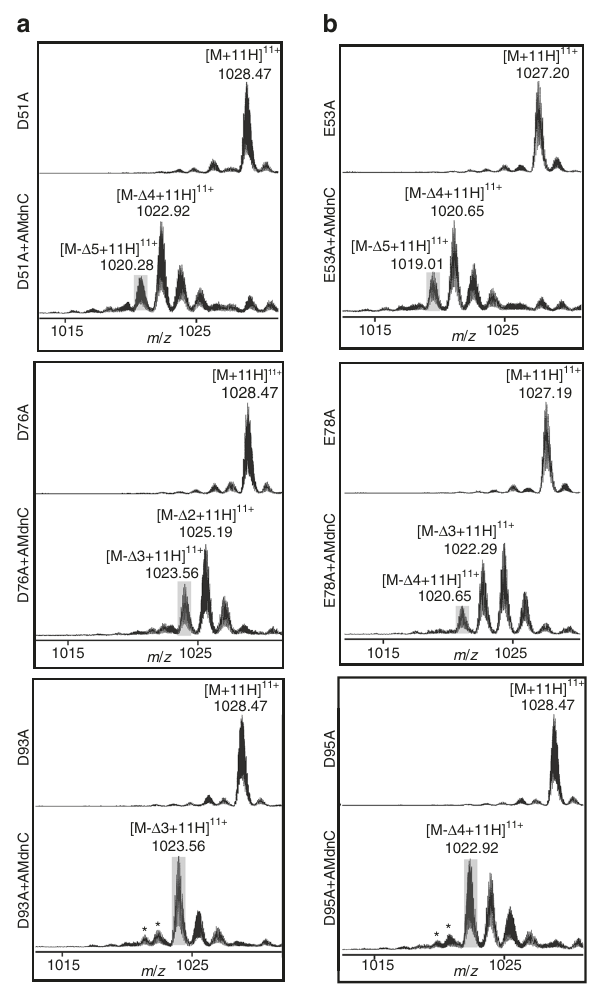
Fig. 6 Topological directionality of AMdnC in processing individual core peptides of AMdnA. a Three key acidic residues required for the formation of the fi rst lactone on each core peptide within AMdnA were individually substituted with alanine. The resultants were used as the substrates of AMdnC. b Three key acidic residues involved in the formation of the second lactone were individually substituted with alanine to create AMdnA mutants as the substrates of AMdnC. The most processed intermediates were shaded in gray. Unrelated minor MS peaks were labeled